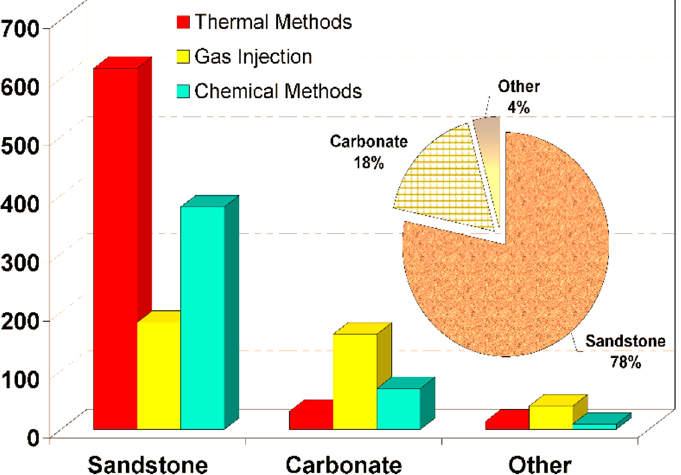
Figure 2. Lithology-based implementation of tertiary EOR methods. Adapted from [37].